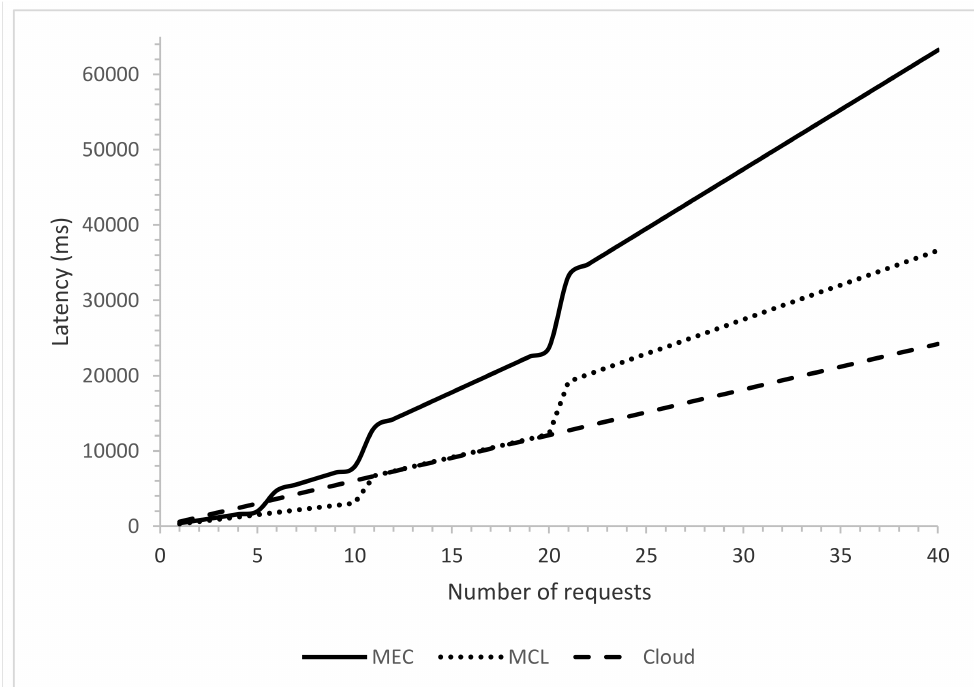
Figure 7. Latency against number of requests.